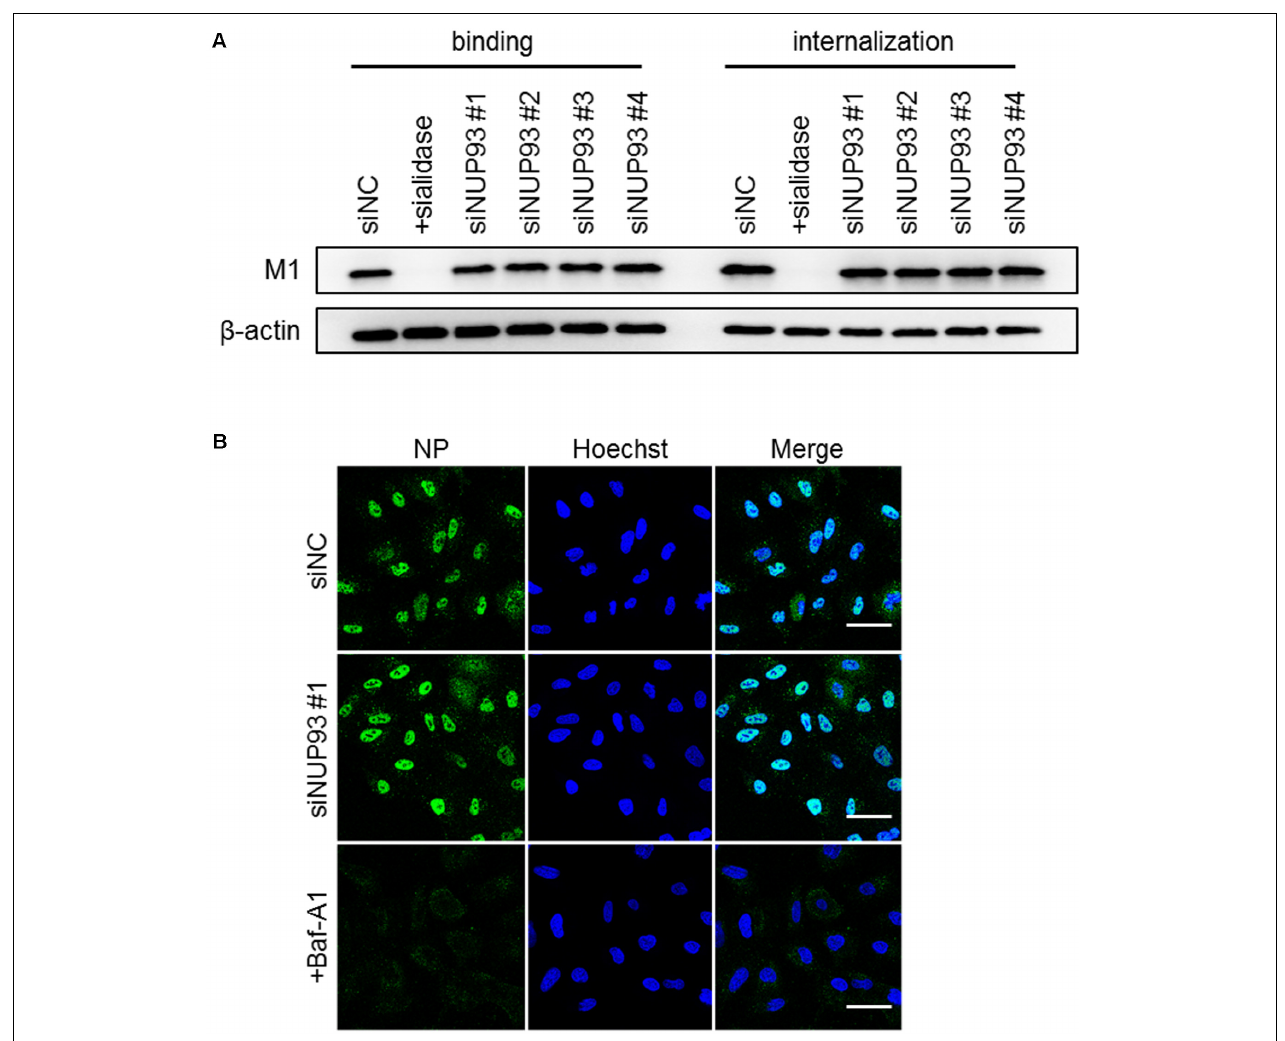
FIGURE 3 | Role of NUP93 in binding, internalization, and nuclear import. (A) A549 cells transfected with siRNAs were infected with WSN virus at an MOI of 10. As a control, cells were pre-treated with sialidase from Arthrobacter ureafaciens for 8 h before the infection. M1 protein in virus particles attaching to cells, or internalized into cells, was detected by Western blotting with anti-WSN antibodies. (B) A549 cells transfected with siRNAs were infected with WSN virus at an MOI of 200 in the presence of CHX. Baf-A1 was used as a positive control. Cells were fixed and permeabilized at 2 h post-infection and then immunostained for NP. The images were obtained using confocal microscopy. Scale bars: 50 µ m. The results are representative of at least three independent